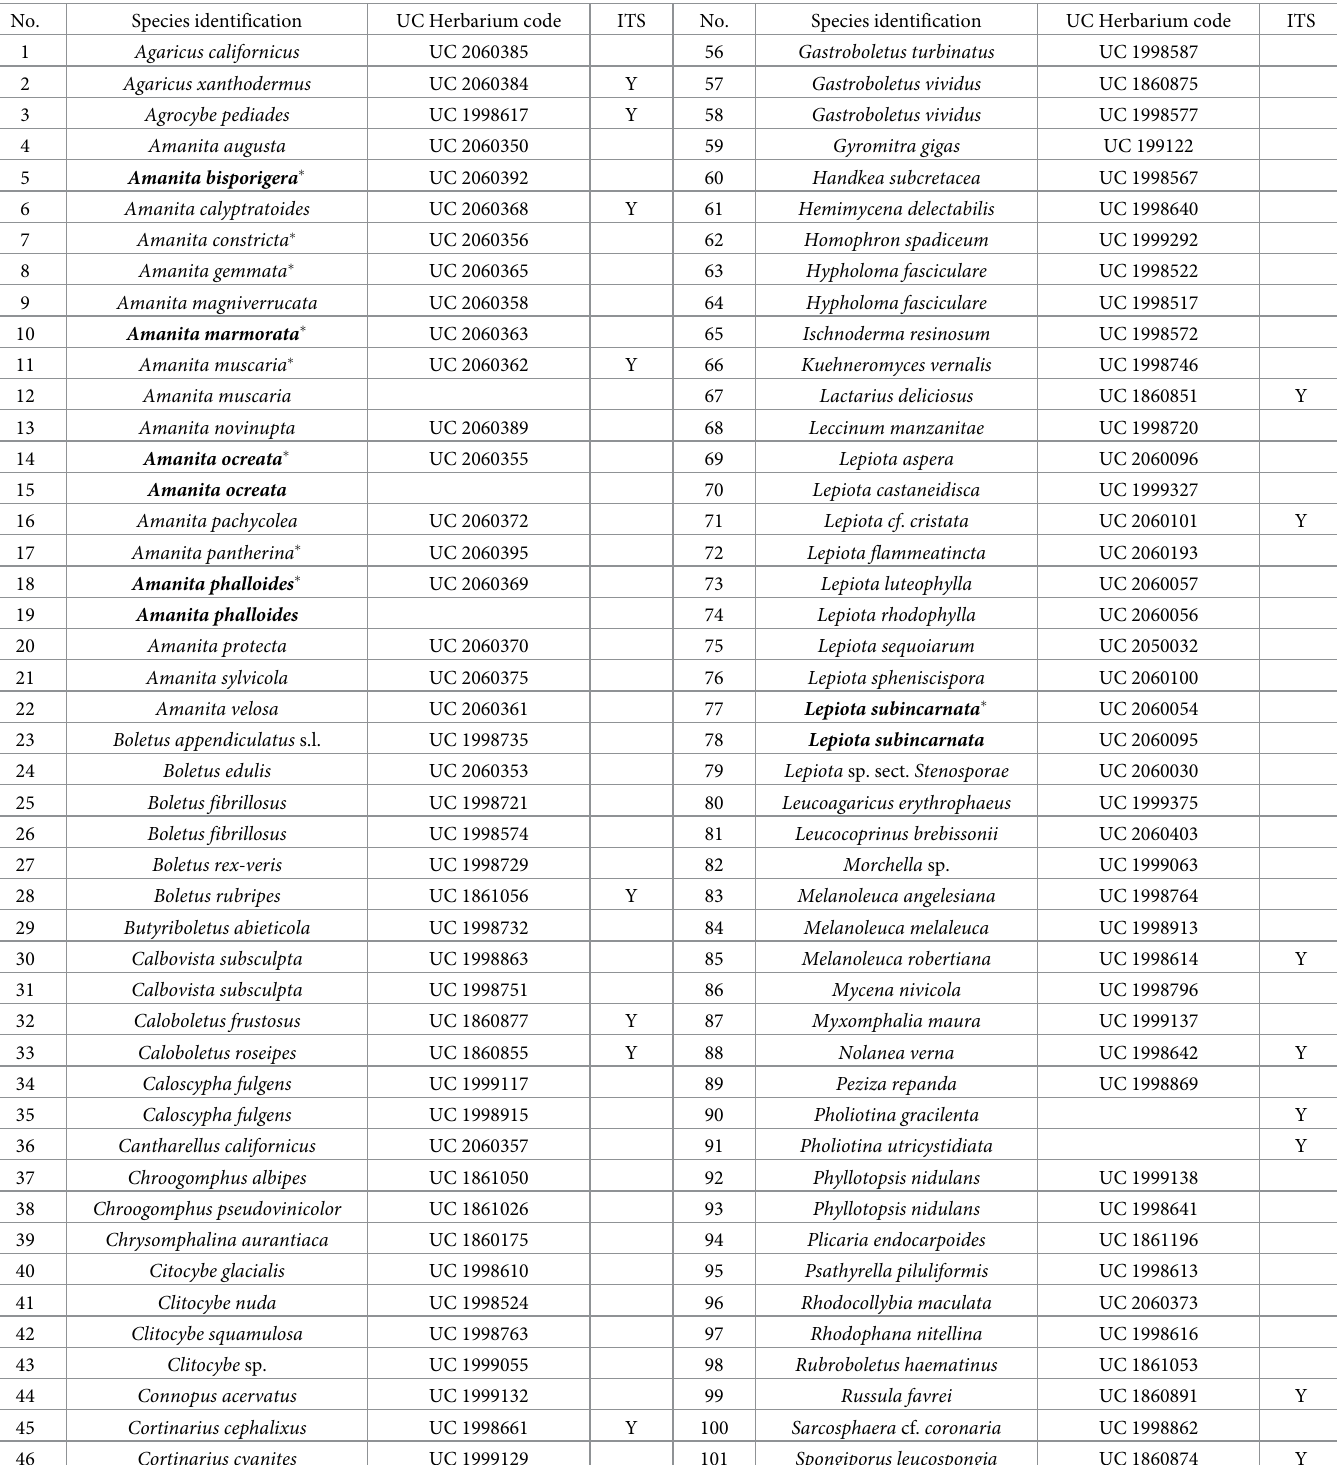
Table 2. Species names and UC Herbarium codes for wild mushrooms sampled in this study and mentioned in Fig 6. A ‘Y” in the “ITS” (internal transcribed spacer) column indicates that the ITS region was sequenced and assigned a species based on the highest percent match when BLAST searched in the NCBI database. Bold text indi- cates those species that are known to contain amatoxins. Those marked with an � were subjected to chemical analysis by LC-MS.